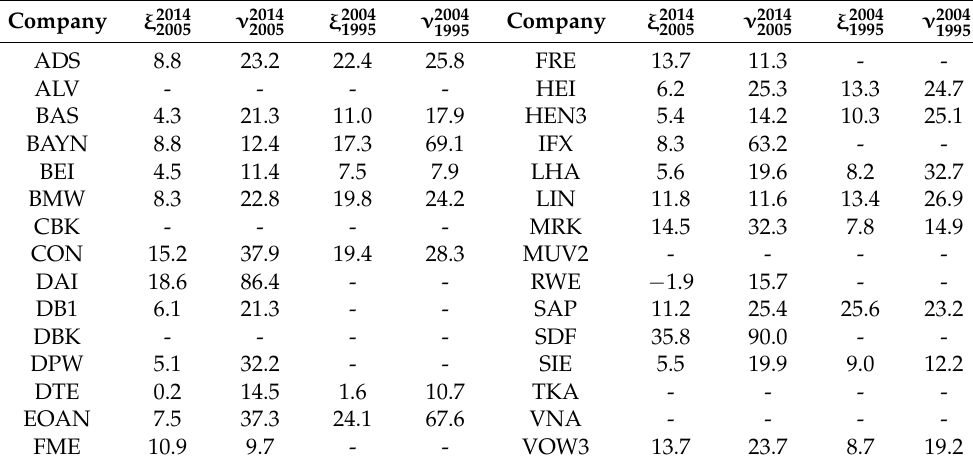
Table A6. Estimated parameters ξ ( % ) and ν ( % ) , for each company of DAX index.